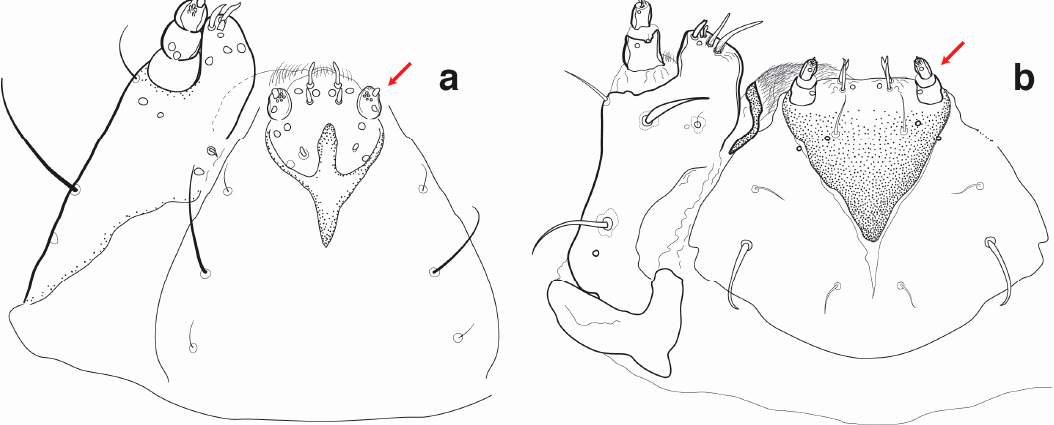
Figure 54. Labium, larva: ( a ) Dryophthorus ; and ( b ) Cosmopolites .